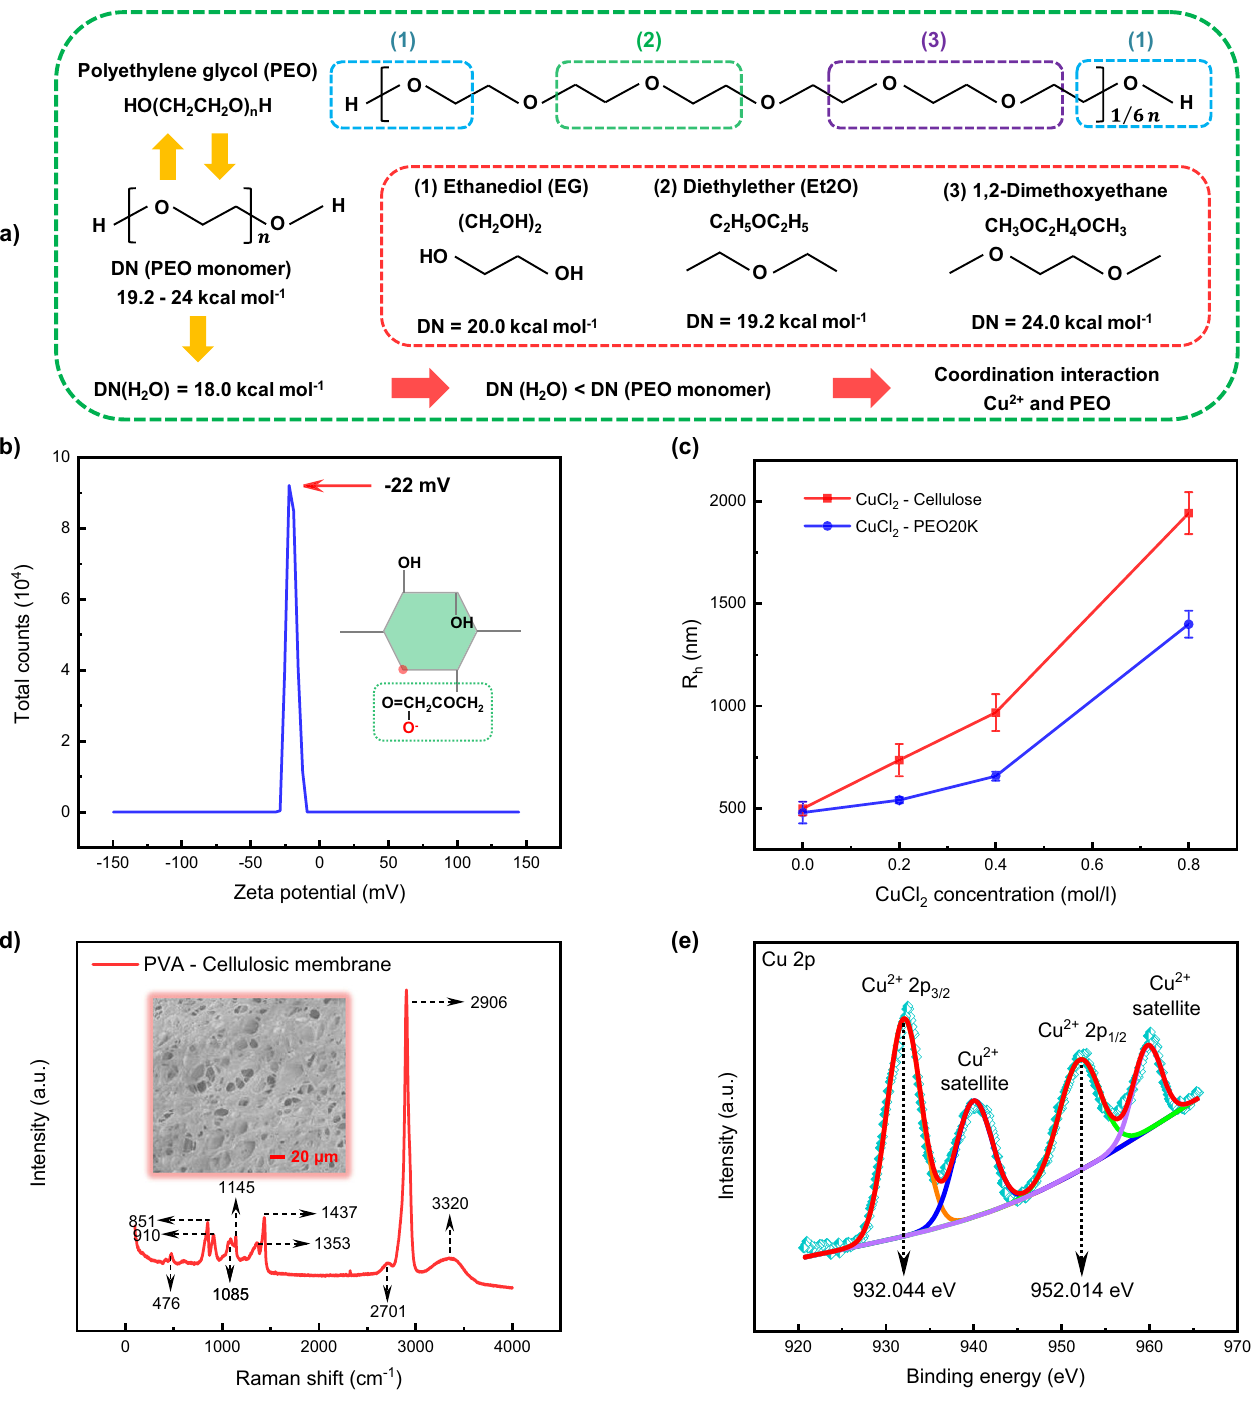
Fig. 2 Characterization of the PVA-cellulosic membrane. a PEO-Cu 2 + coordination interaction based on Gutmann ’ s donor rule in aqueous solution. b Zeta potential of the cellulose aqueous solution. c Hydrodynamic radius of diluted CuCl 2 -cellulose and CuCl 2 -PEO aqueous solutions. d Raman peak of the PVA-cellulosic membrane. The inset was the SEM image of the PVA-cellulosic membrane. e High-resolution Cu 2p photoelectron spectra of the CuCl 2 - [PVA-cellulosic membrane]. spectroscopy was used to analyze the crystallinity of the PVA gel stronger. Considering the low solid content and high viscosity of matrix in the cellulose dry fi lm (Fig. 2d) 36,37 . 1142 cm − 1 is the cellulosic aqueous solutions, it was necessary to prepare the porous fi ngerprint peak of PVA crystallinity. It is the C-C stretching vibration PVA-cellulose dry templates (2 mm-thick) by freeze-drying in the design of the synergistically enhanced Cu 2 + coordination by PEO and peak related to the C-O stretching vibration, that is, the symmetrical cellulose. In addition, the Coulomb repulsive force between COO − stretching vibration peak of O-C-C. Moreover, the pore size of the PVA-cellulosic membrane was about 10 – 20 μ m (inset of Fig. 2d and functional groups in the cellulose chain is also the main consideration Supplementary Fig. 1). This provided the necessary conditions for the for using PVA as a cellulose gel matrix. Speci fi cally, Raman npj Flexible Electronics (2022)